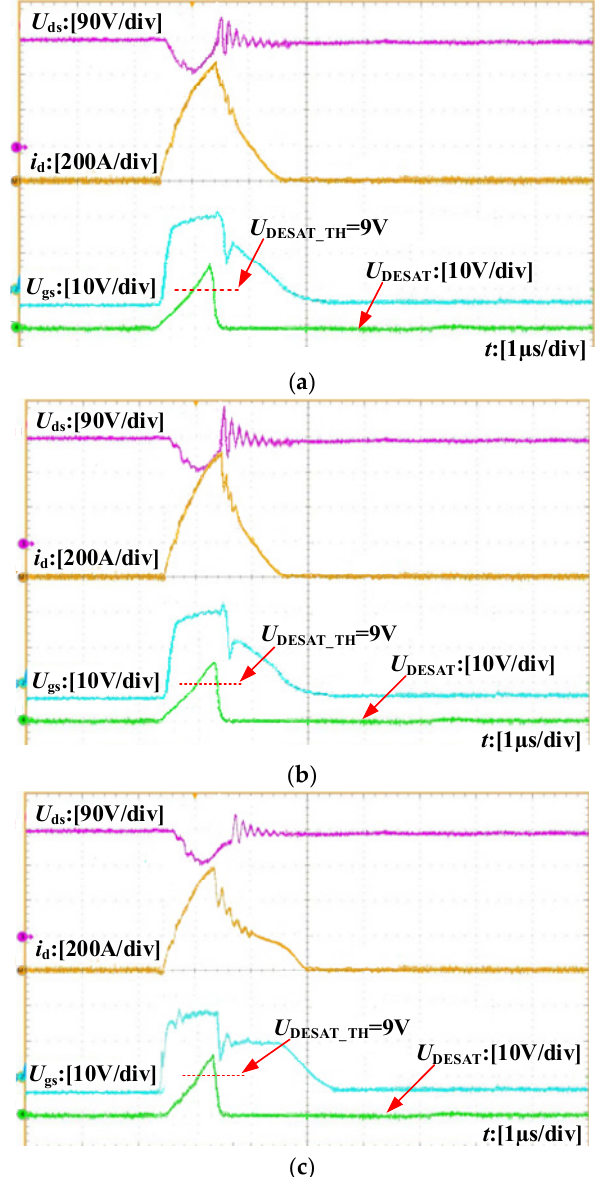
Figure 12. Short-circuit waveforms under different clamping methods: ( a ) gate-source voltage clamping; ( b ) Zener diode clamping; ( c ) soft switching-off circuit.